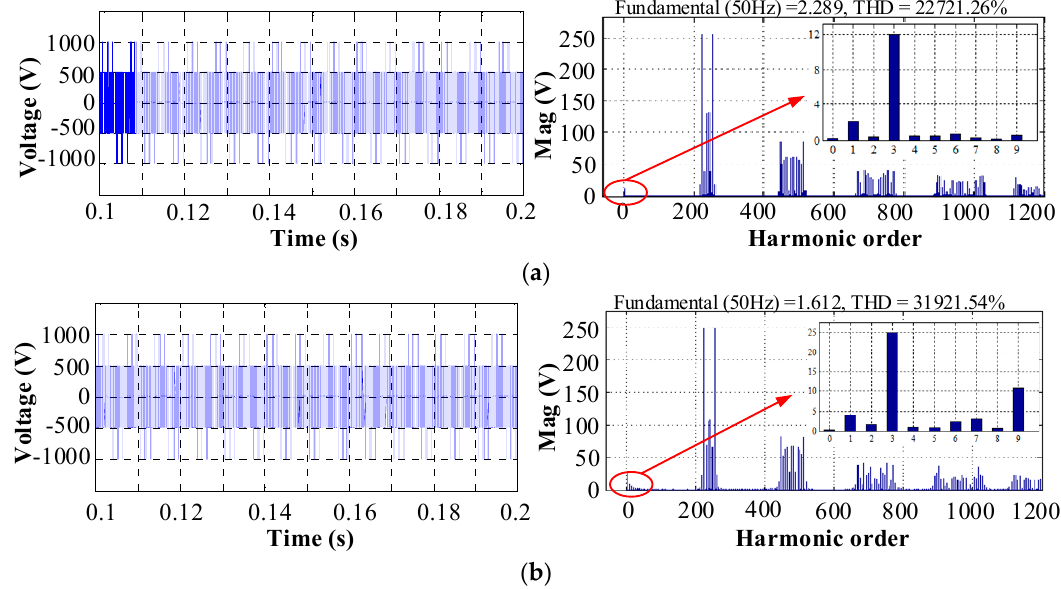
Figure 8. The waveforms and corresponding the fast Fourier transformation (FFT) analysis of the CMV between N and reference ground: ( a ) without SPWM dead time; ( b ) with SPWM dead time.